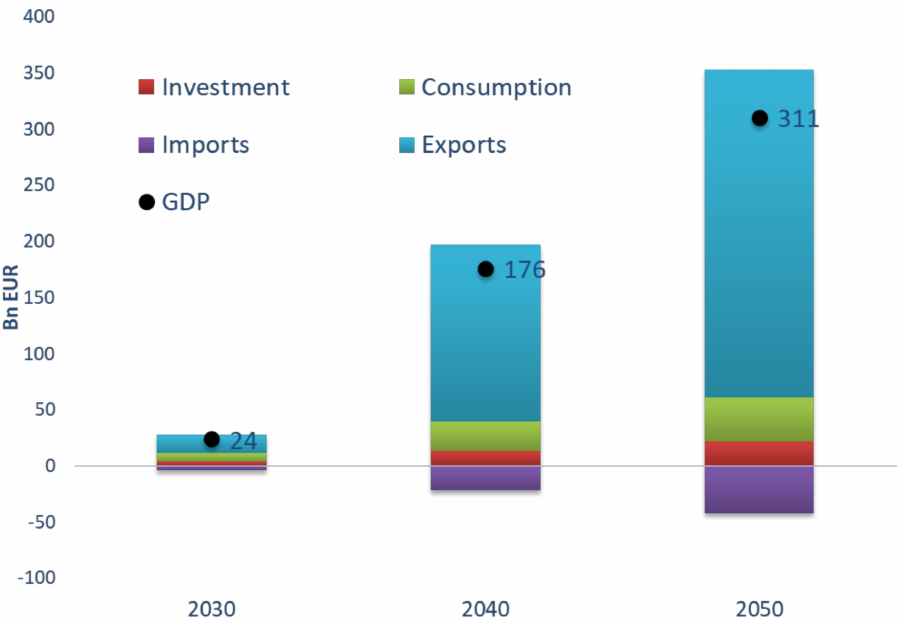
Figure 11. Changes in GDP components in 2DEG_COMB relative to